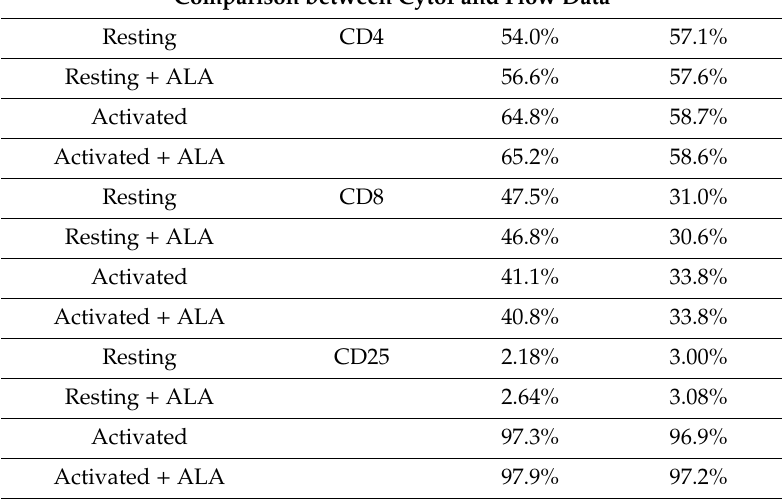
Table A1. Cont. Comparison between Cytof and Flow